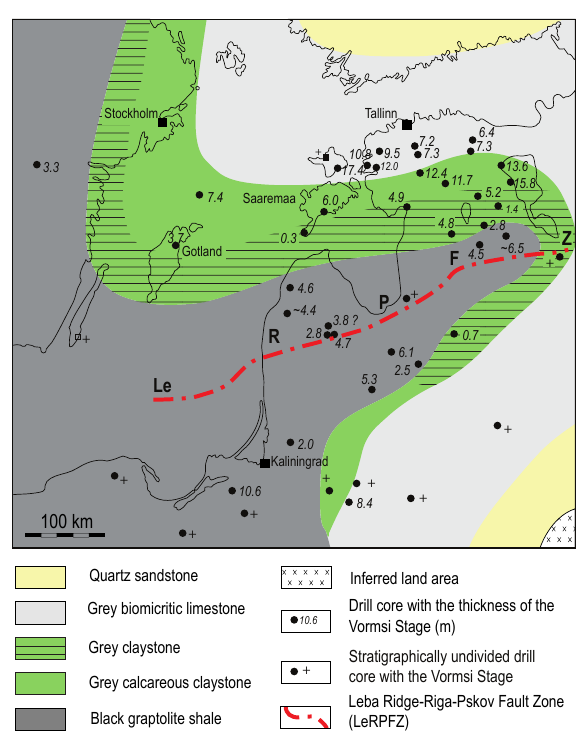
Fig. 4. Sketch of the facies and thickness distribution of the Baltic Basin with the evolving Livonian Tongue around the LeRPFZ in late Katian (Vormsi) time (modified after Männil